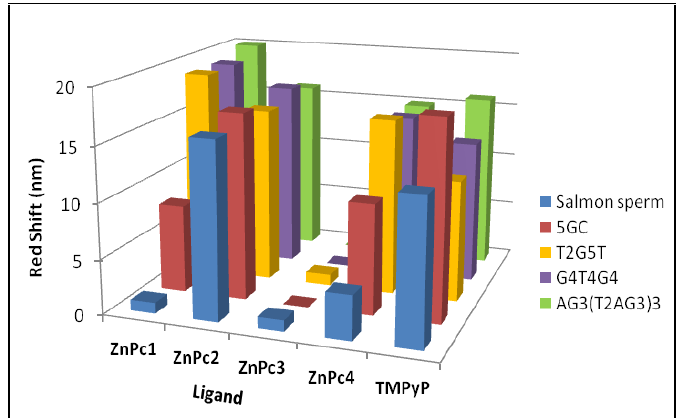
Figure 13. Red shifts obtained in the UV-Vis titration with the selected ligands and DNA sequences.